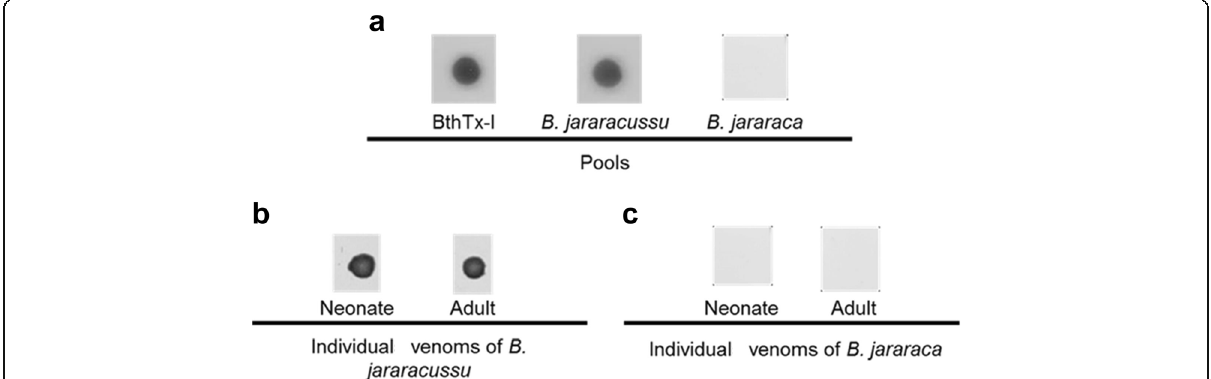
Fig. 1 Species-specific recognition of anti-BthTx-I against B. jararacussu and B. jararaca venom. The purified antibodies were tested against ( a ) pools, individual venoms of ( b ) B. jararacussu and ( c ) southeastern B. jararaca of different ages (neonate and adults) through dot blot. One microgram of each